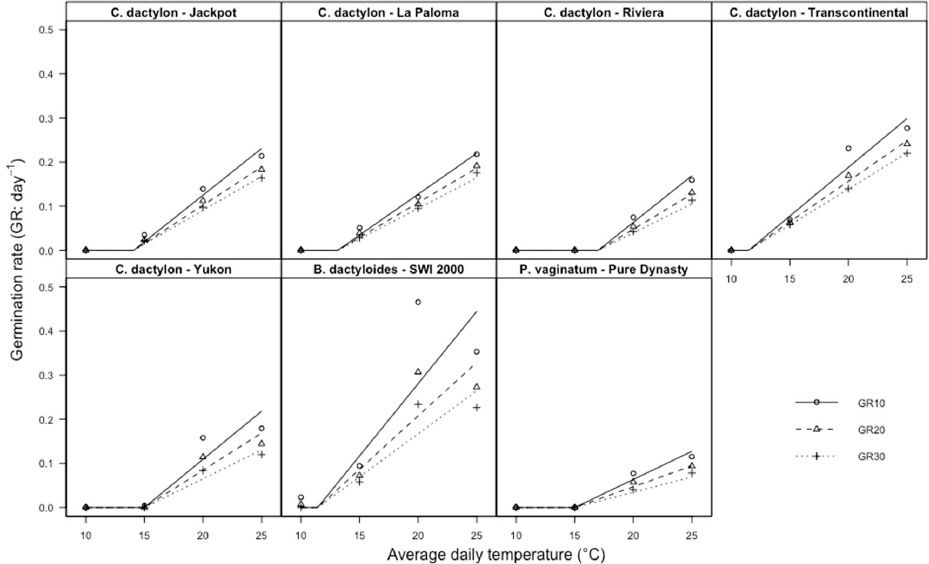
Figure 2. Germination rates of the 10th, 20th and 30th percentiles for seven cultivars of warm-season turfgrass species (Jackpot, La Paloma, Transcontinental, Yukon, SWI 2000, Pure Dynasty) subjected to four temperature regimes (20/30 °C, 15/25 °C, 10/20 °C, 5/15 °C, corresponding, respectively, to average daily temperatures of 25°C, 20°C, 15°C and 10°C) [27]. For all cultivars, except for ‘SWI 2000 ′ , the fitted lines are very close (Figure 2) and, therefore, the thermal times required to reach 10, 20 and 30% germination ( θ T(10) , θ T(20) , and θ T(30) ) were very similar (Table 3). Table 3. Thermal-time parameters of seven cultivars of warm-season turfgrass species as obtained by nonlinear regression (Equation (1); [27]) (standard errors are in parentheses). Species